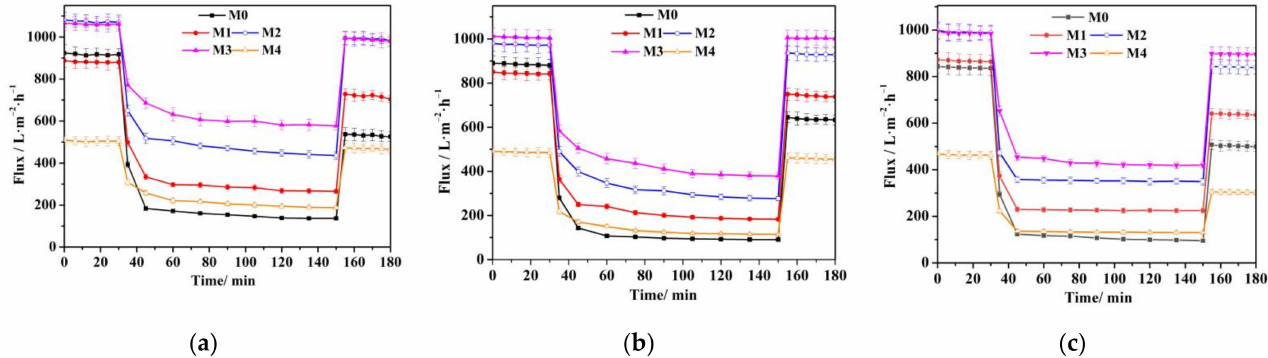
Figure 6. Water flux changes with filtration time for the various prepared membranes during the filtration of ( a ) BSA